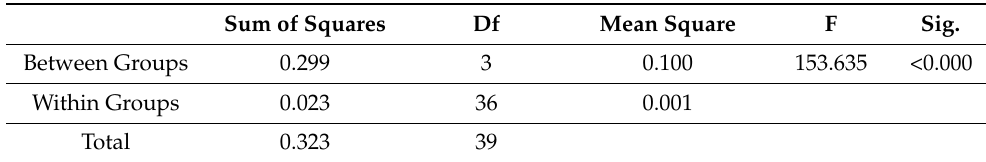
Table 9. ANOVA test for the NAF values of different concentrations of P-Lip-treated cells and control cells. Sum of Squares Df Mean Square F Sig. Between Groups 0.299